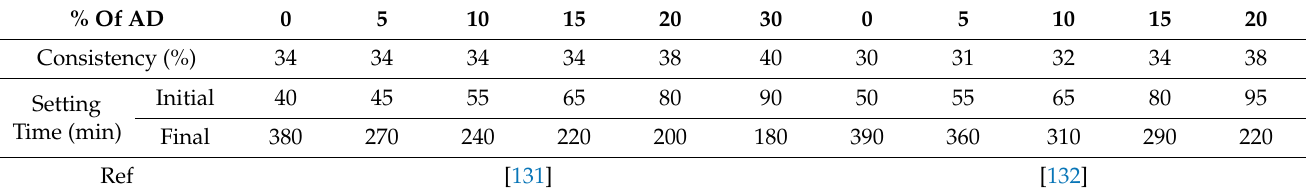
Table 9. Influence of AD on the properties of concrete.